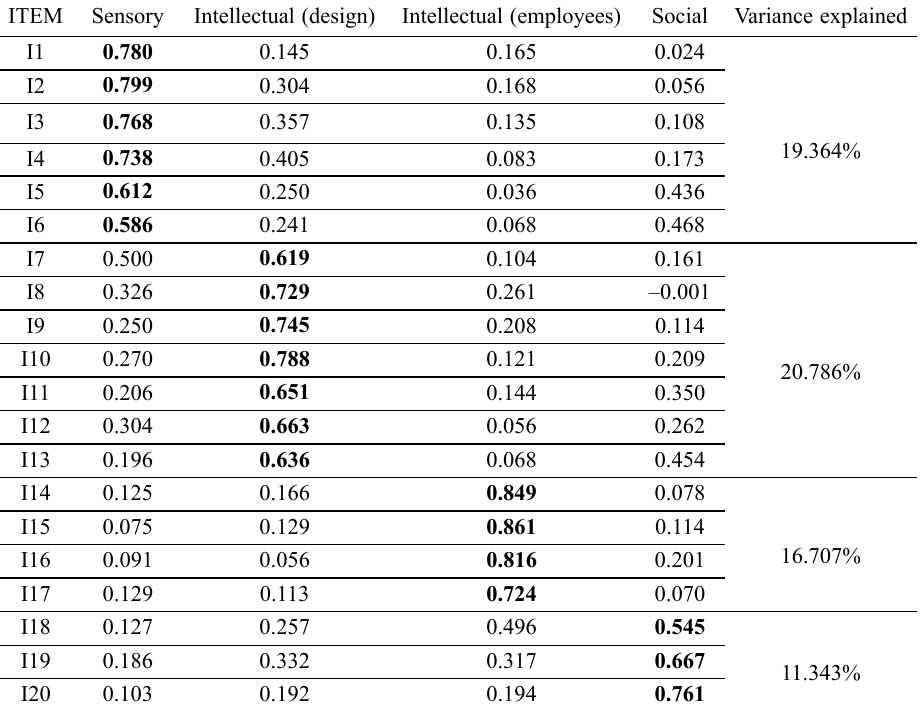
Table 3. EFA: consumer experience